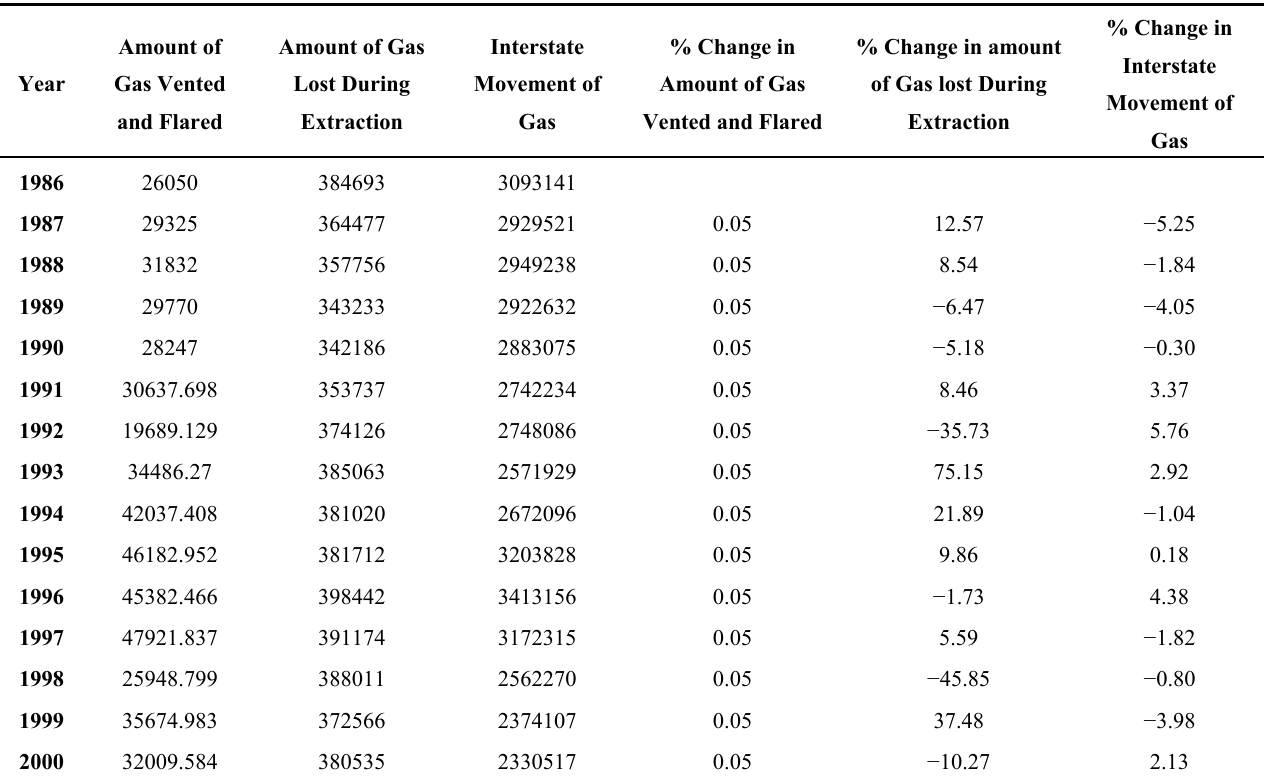
Table 5. Environmental Change Indicators during Oil and Gas Activities in Texas and Percentage of